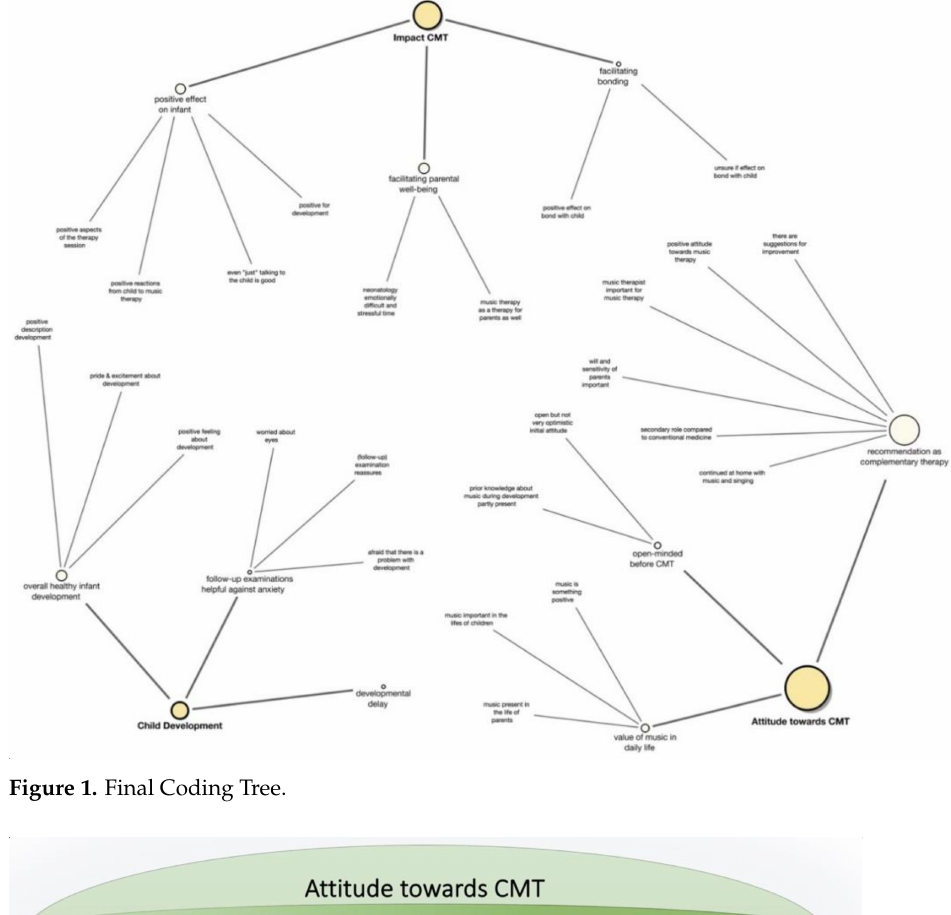
Figure 1. Final Coding Tree.